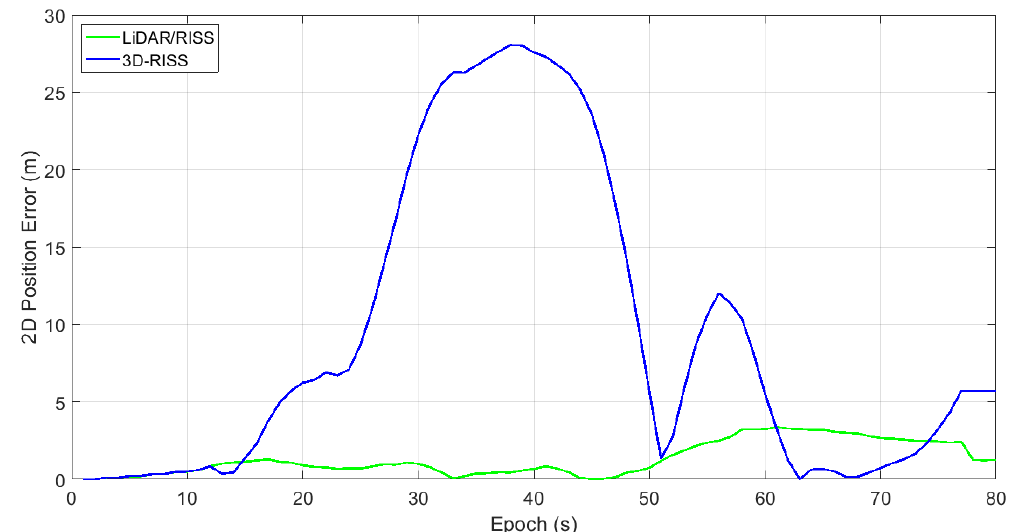
Figure 18. 2D Position Error for Outage 2, First Trajectory.